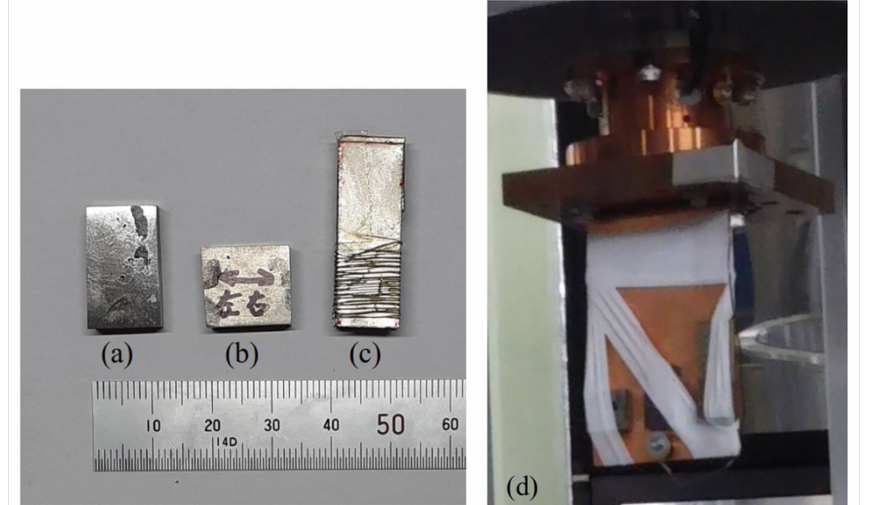
Figure 4. Photograph of the sample condition for the neutron measurement: ( a ) d 0 sample of the titanium manufactured by the spot weld of titanium plates without tungsten fibers; ( b ) the W/Ti composite material; ( c ) tungsten sample for d 0 measurement, where tungsten fiber is loosely wrapped around a titanium plate; ( d ) the sample setting condition on the cryostat cooling head. Three samples were fixed with a thin white water leak prevention